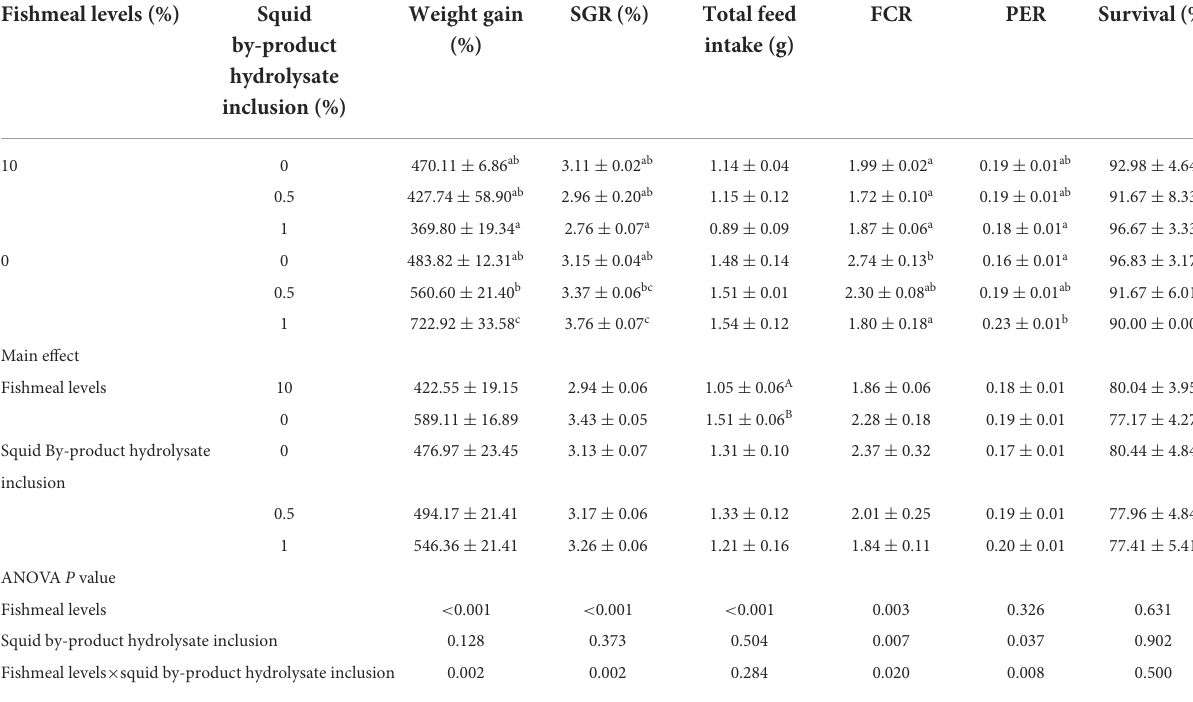
TABLE 5 Growth performance of shrimp fed with plant protein-based diets supplemented with squid by-product hydrolysate. Fishmeal levels (%) Squid by-product